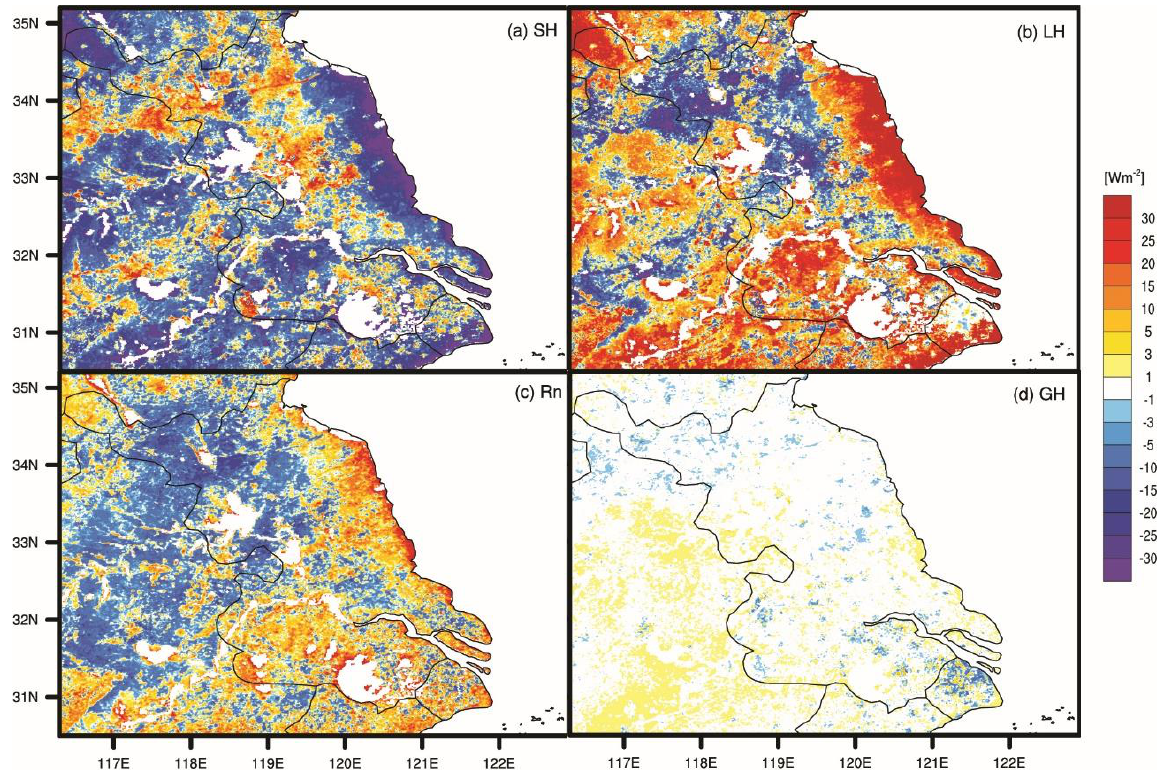
Figure 10. Spatial distribution of mean surface energy differences (unit: Wm − 2 ) between CTL and CHAR experiments over the research period in EC: ( a ) sensible heat flux, ( b ) latent heat flux, ( c ) net radiation flux, and ( d ) ground heat flux.